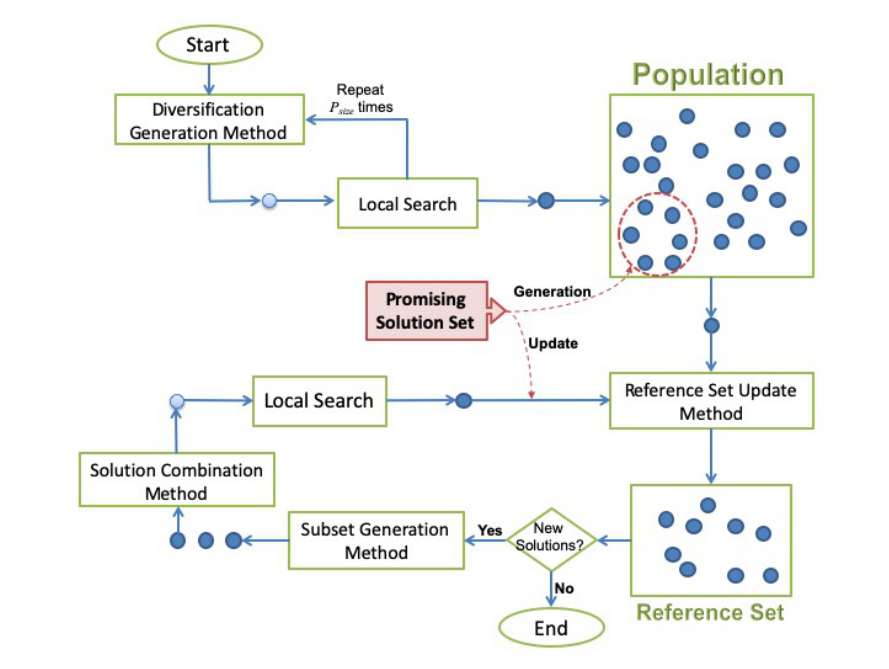
Figure 1. ASS-MCDS (adaptive scatter search ) flowchart.